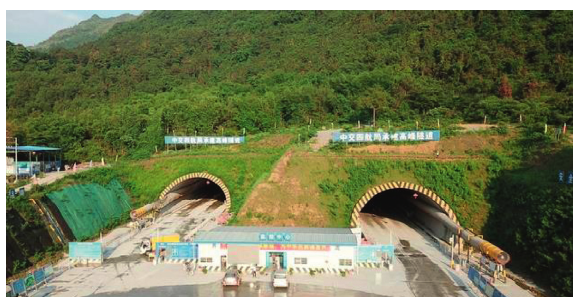
Figure 2: The construction site of Case 7 during the lockdown